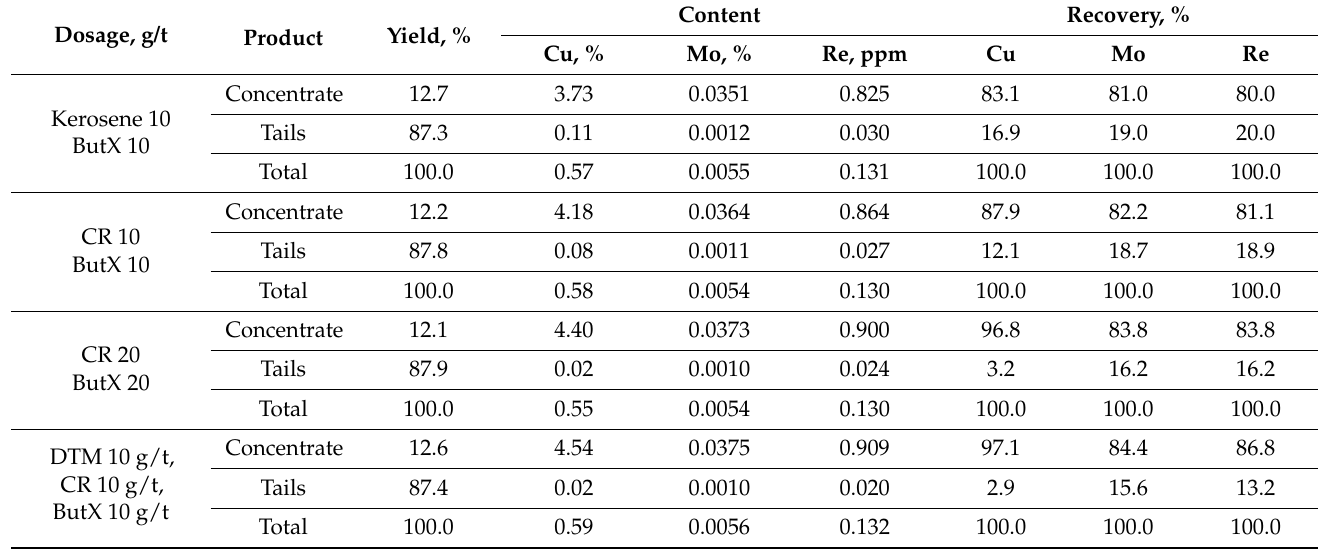
Table 1. Results of copper–molybdenum–porphyry ore bulk